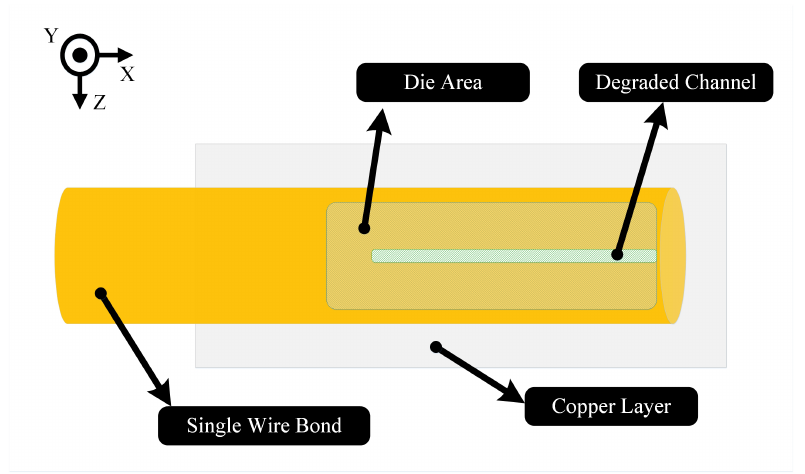
Figure 15. Scenario 1 failure simulation in 3D FEM